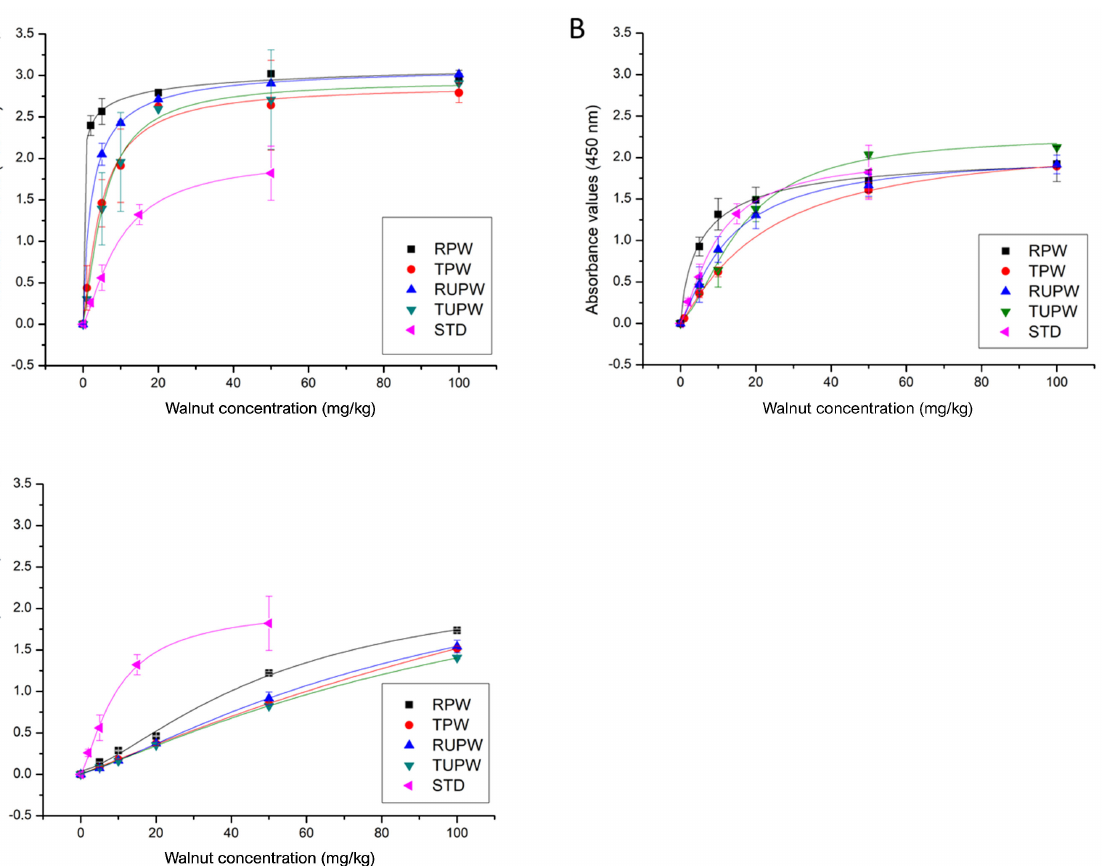
Figure 1. ELISA results obtained from experimental walnut/corn flour binary mixtures prepared with raw peeled walnut (RPW, (cid:4) ), toasted peeled walnut (TPW, • ), raw unpeeled walnut (RUPW, (cid:78) ), and toasted unpeeled walnut (TUPW, (cid:72) ) using the Alertox ® walnut ELISA kit. The protein extracts from binary mixtures were used undiluted (A) or diluted 1:5 (B) or 1:25 (C) in protein extraction buffer, and results were compared with the standard curve obtained with the ready-to-use standards provided with the kit (STD, (cid:74) ). Points represent the mean value ± SD ( n = 2; 3 independent